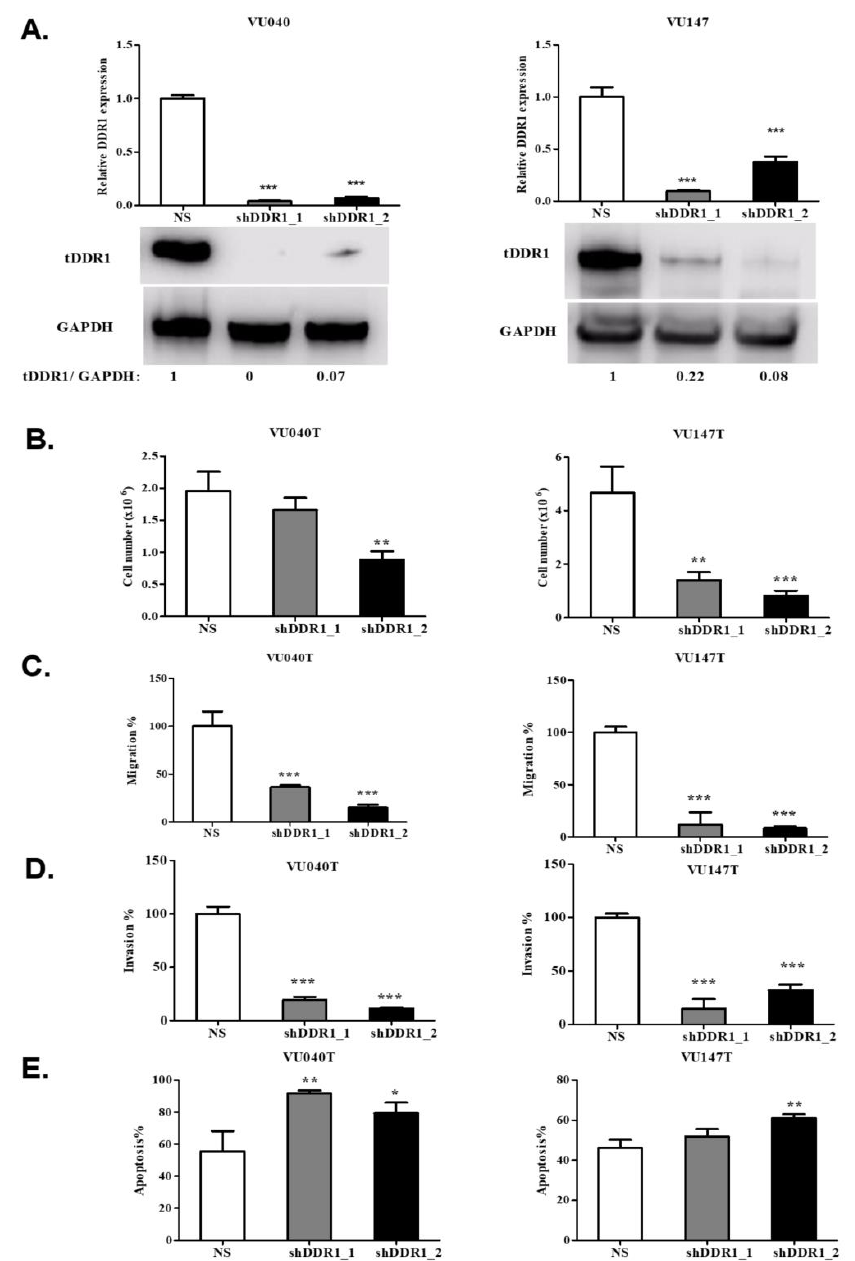
Figure 6. The effects of collagen are mediated by discoidin domain receptor 1 (DDR1). ( A ) Knockdown of DDR1 following stable transduction of VU040 and VU147T cells with two independent short hairpin RNAs. RT-qPCR showed a marked reduction in DDR1 mRNA (top panel) and total DDR1 protein levels (bottom panel). The expression of DDR1 mRNA in NS (control) cells was normalized to 1. ( B ) Following DDR1 knockdown, VU040 and VU147T cells grew slower compared to NS controls in the presence of collagen. ( C ) Knockdown of DDR1 inhibited the migration of VU040T and VU147T cells pre-treated with collagen in Transwell assays. ( D ) Knockdown of DDR1 inhibited the invasion of VU040T and VU147T cells through matrigel-coated filters in Transwell assays. ( E ) The protective effects of collagen on cisplatin-induced apoptosis were reversed following DDR1 knockdown. Results shown are mean +/- standard deviation values of triplicates. *, **, *** denotes p < 0.05, p < 0.01 and p < 0.001 and p < 0.0001 respectively.